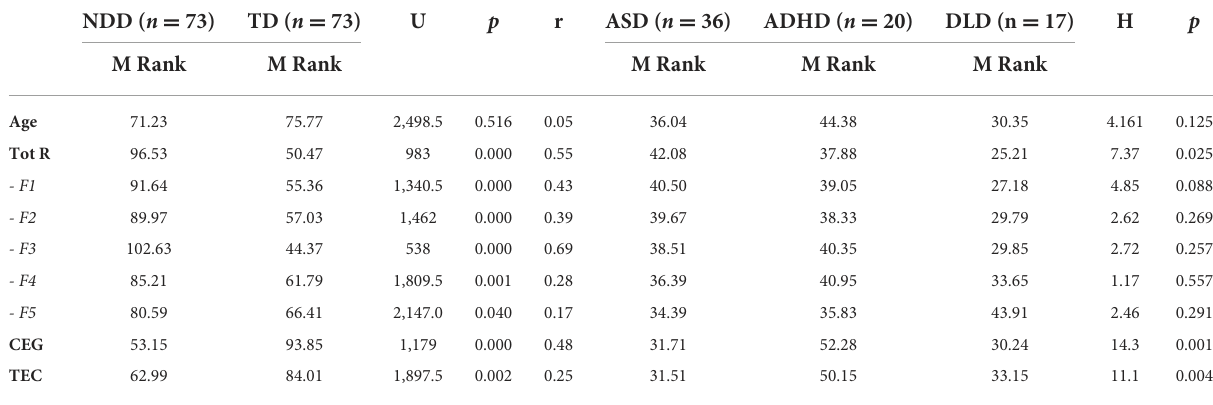
TABLE 1 Mean ranks and between-group comparisons between children with NDD ( n = 73) and children with TD ( n = 73) on Resilience Scale (Total and Factors: F1, F2, F3, F4, and F5), structural language and social cognition measures; and comparison of subgroups per separate: ASD, ADHD, and DLD.